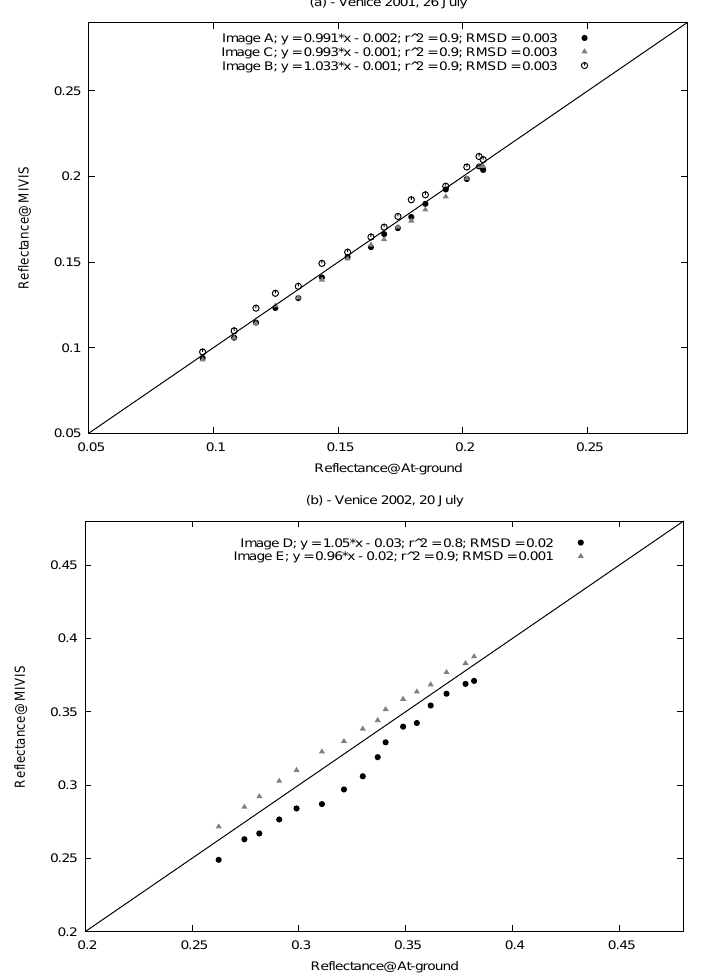
Figure 5 . The linear fit of the study area’s measured reflectance (Reflectance@At-ground) and the reflectance retrieved from Module B for all of the MIVIS channels (Reflectance@MIVIS) for the image acquired on (a) July 26, 2001 and (b) July 20,